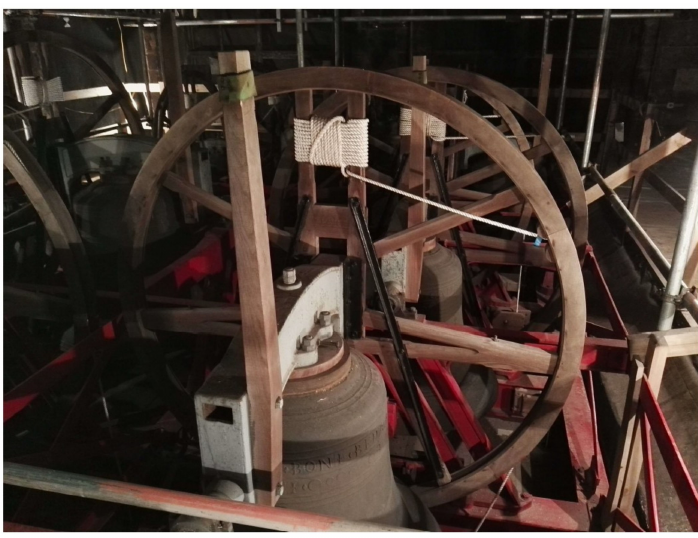
Figure 1. Image of the fifth bell and its bell wheel in Durham